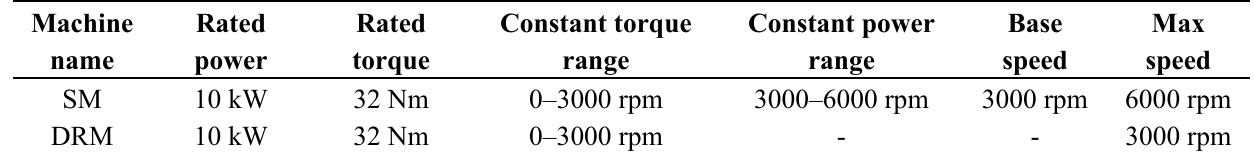
Table 12. Specifications of the prototype.